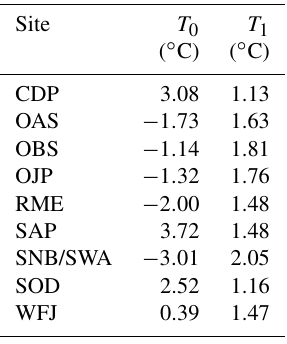
Table 4. Precipitation phase factors fitted to GSWP3 data at site locations (Senator Beck and Swamp Angel are located within the same 0.5 ◦ grid cell).